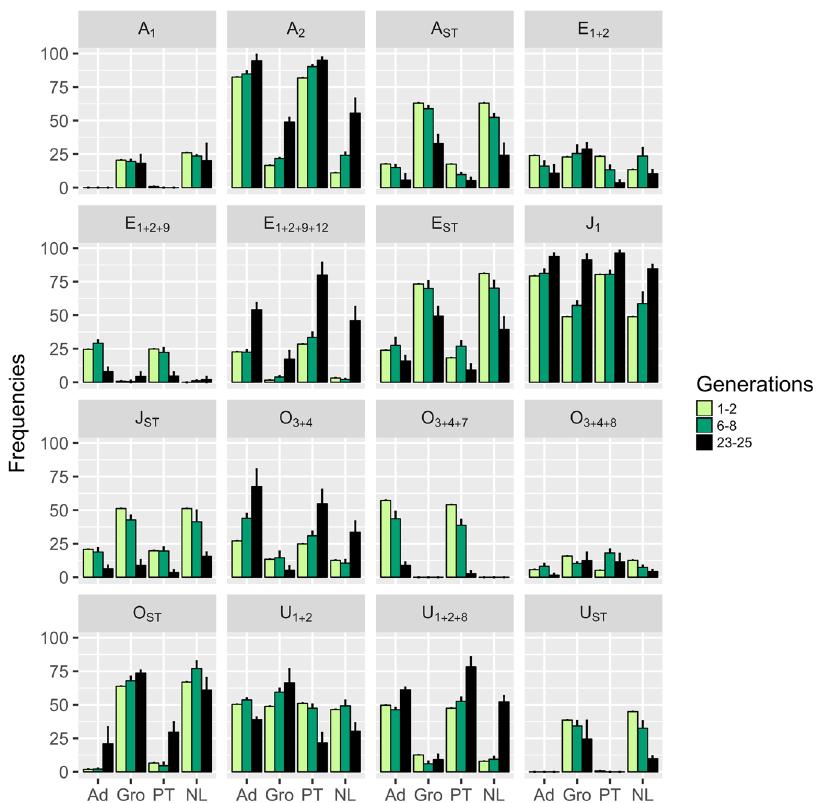
Figure 3. Frequency of chromosomal arrangements across generations and foundations. Error bars correspond to the standard error calculated from the differences among the three replicate populations of each foundation. See details in the Methods